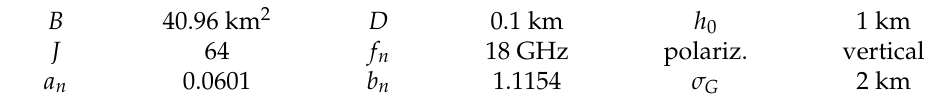
Table 1. Simulation parameters employed for every